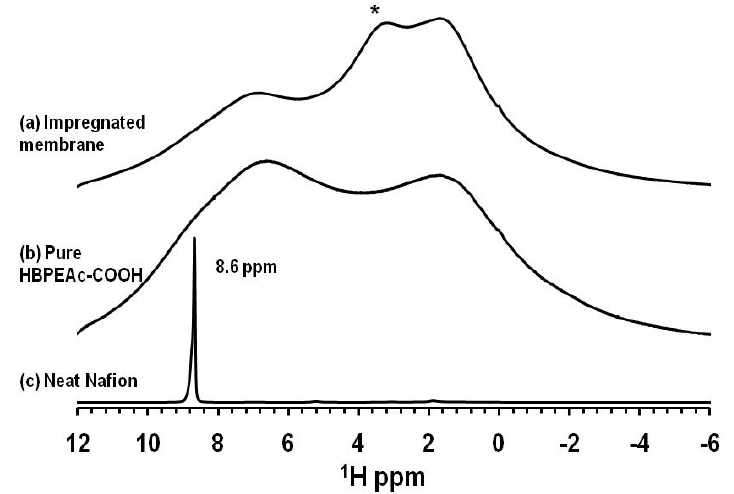
Figure 5. 499.5 MHz 1 H DP/MAS SSNMR spectra of ( a ) impregnated membrane; ( b ) pure HBPEAc-COOH; and ( c ) pure Nafion. The single narrow line at the chemical shift of 8.6 ppm in (c) indicates the presence of approximately 2 H The peak in (a) labeled with * is due to the